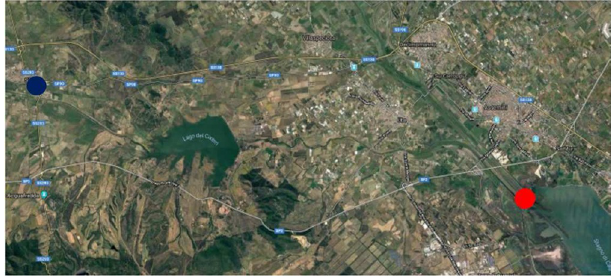
Fig. 2. Satellite framing of the case study.